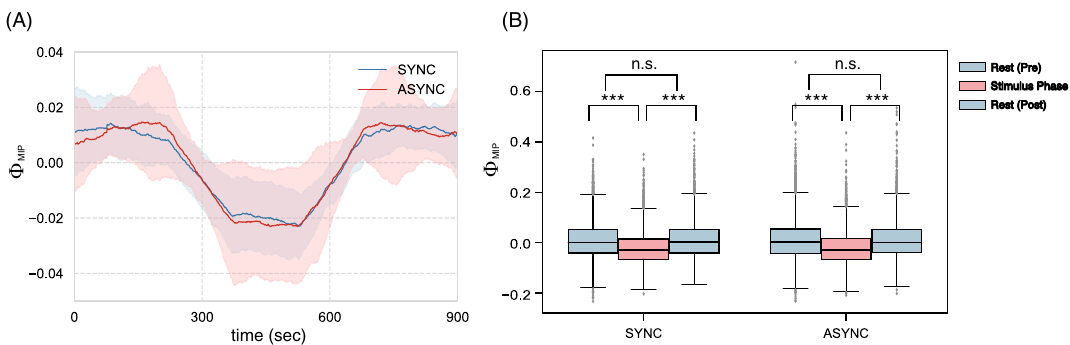
Figure 1. ( A ) Time series of mean (cid:31) MIP for both conditions (blue: SYNC, red: ASYNC). The stimulus phase covers 300 − 600 s. The other regions indicate resting states (no stimulus). The computational time frame for IIT is 250 (2 s). A moving-average (sample length 150 steps) was calculated in the time series to make temporal changes of values easy to see (Niigata) (cid:31) MIP of SYNC and ASYNC values drops significantly compared